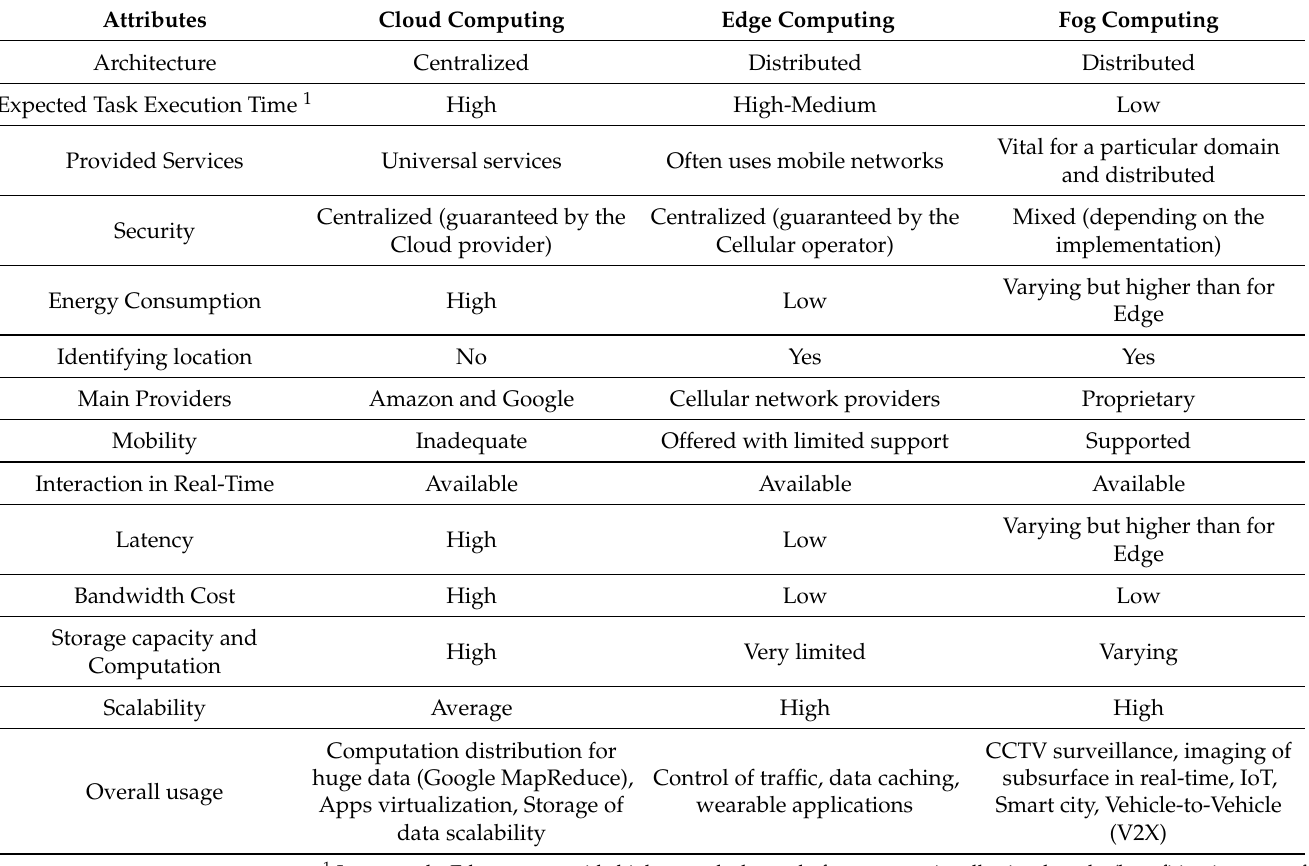
Table 1. Comparison on different computing